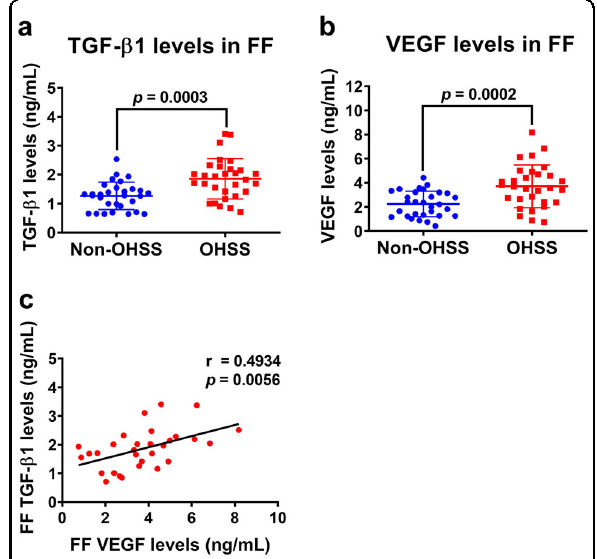
Fig. 7 TGF- β 1 and VEGF protein levels are increased in the follicular fl uid of patients with OHSS. a , b TGF- β 1 ( a ) and VEGF ( b ) protein levels in the follicular fl uid of patients without OHSS ( n = 30) and with OHSS ( n = 30) were examined by ELISA. The results are expressed as the mean ± SD. The values without a common letter are signi fi cantly different ( p < 0.05). c Pearson ’ s correlation analysis was performed to examine the correlation coef fi cient between two values. TGF- β 1 protein levels were positively correlated with VEGF protein levels in the follicular fl uid of patients with OHSS ( n =